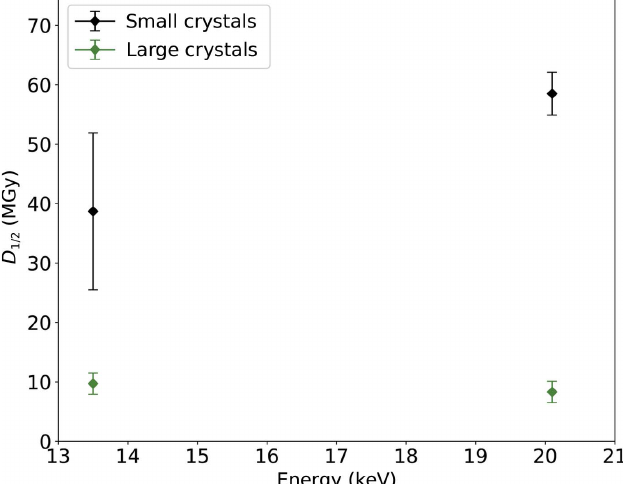
Figure 4 Average D 1/2 values from all 106 crystals plotted for both crystal sizes and energies. The error bars correspond to the standard deviations of the D 1/2